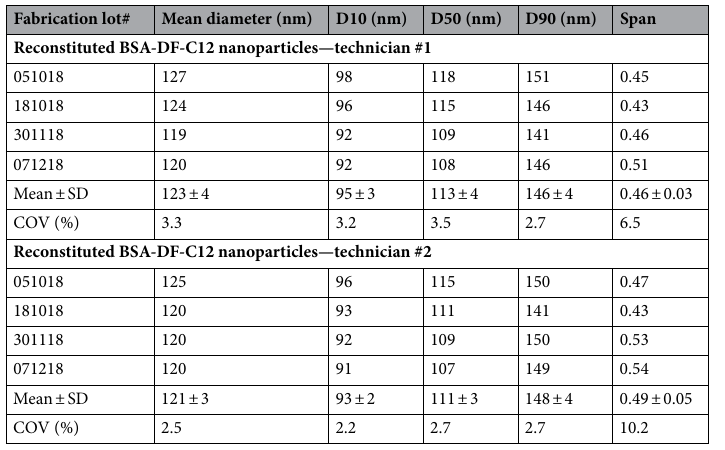
Table 3. Comparison of the reconstitution of BSA-DF-C12 between technicians. SD standard deviation of the mean.